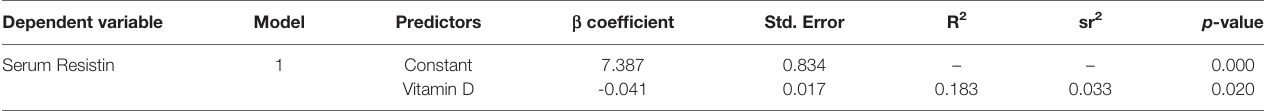
TABLE 3 | Multivariate regression analysis showing independent predictors of serum resistin levels in postmenopausal females. Dependent